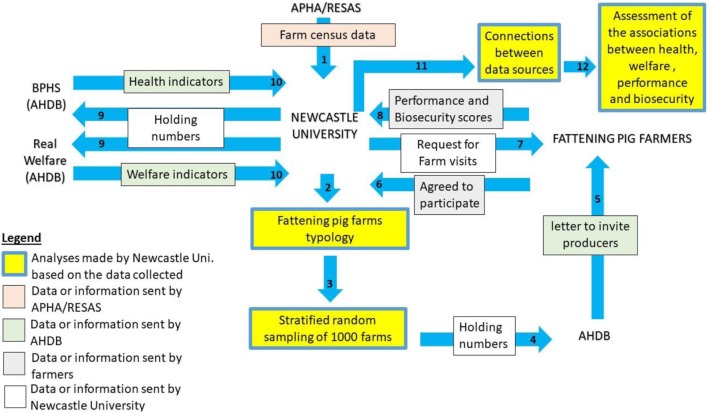
Diagram representing the sampling and data collection. Data about biosecurity, health, welfare, and performance were collected on-farm and from the Agricultural and Horticultural Development Board (AHDB) databases [British Pig Health Scheme (BPHS) and Real Welfare schemes]. The sampling was based on farm census data from the Animal and Plant Health Agency (APHA) and the Rural and Environment Science and Analytical Services (RESAS). The numbers on the graph indicate the order of the different steps in the data collection and the data analysis.